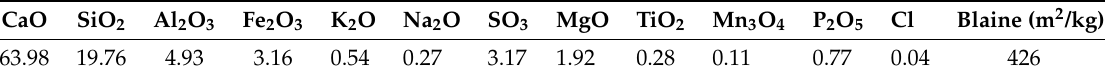
Table 1. Selected compositional data of CEM I 52,5 N(wt